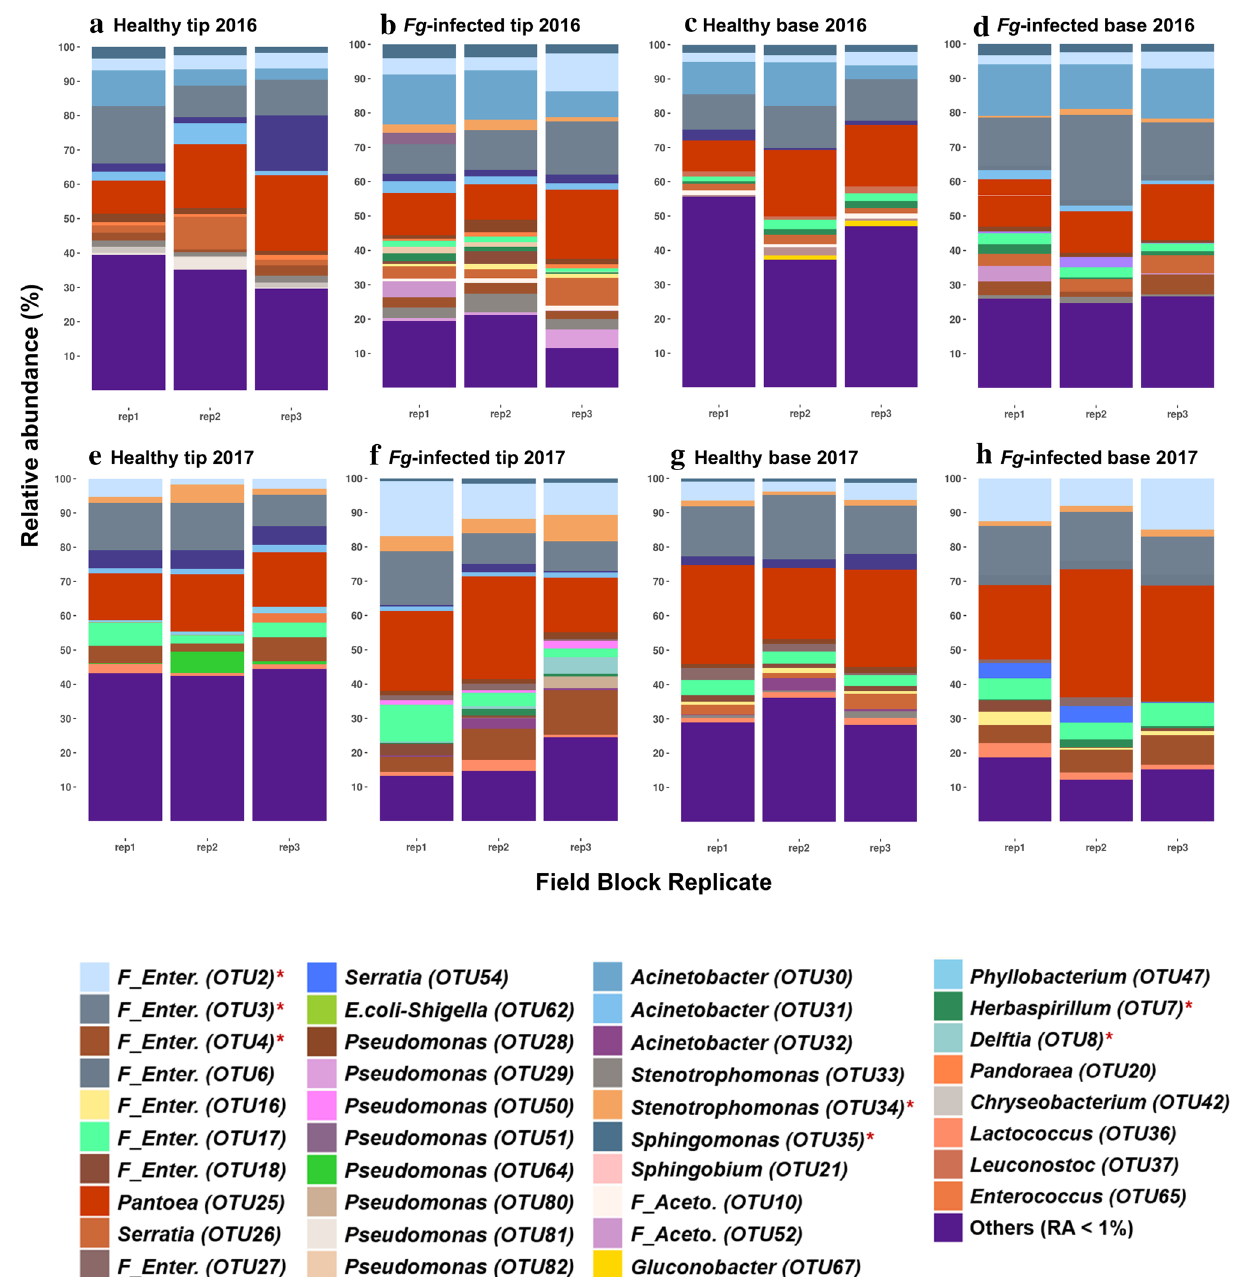
Figure 2. Impacts of field block location, year and Fg infection on TSM composition. ( a – h ) Bar charts of dominant TSM taxa (relative abundance (RA) ≥ 1%) at 3 field blocks (rep1, rep2, rep3) calculated at the OTU level for healthy transmitting silks in 2016 of ( a ) tip and ( c ) base tissues, and 2017 of ( e ) tip and ( g ) base tissues, and Fg -infected silks in 2016 of ( b ) tip and ( d ) base tissues, and 2017 of ( f ) tip and ( h ) base tissues. OTUs with RA < 1% were grouped and labeled as “Others”. Taxa tagged by a red asterisk denote consistent Fg